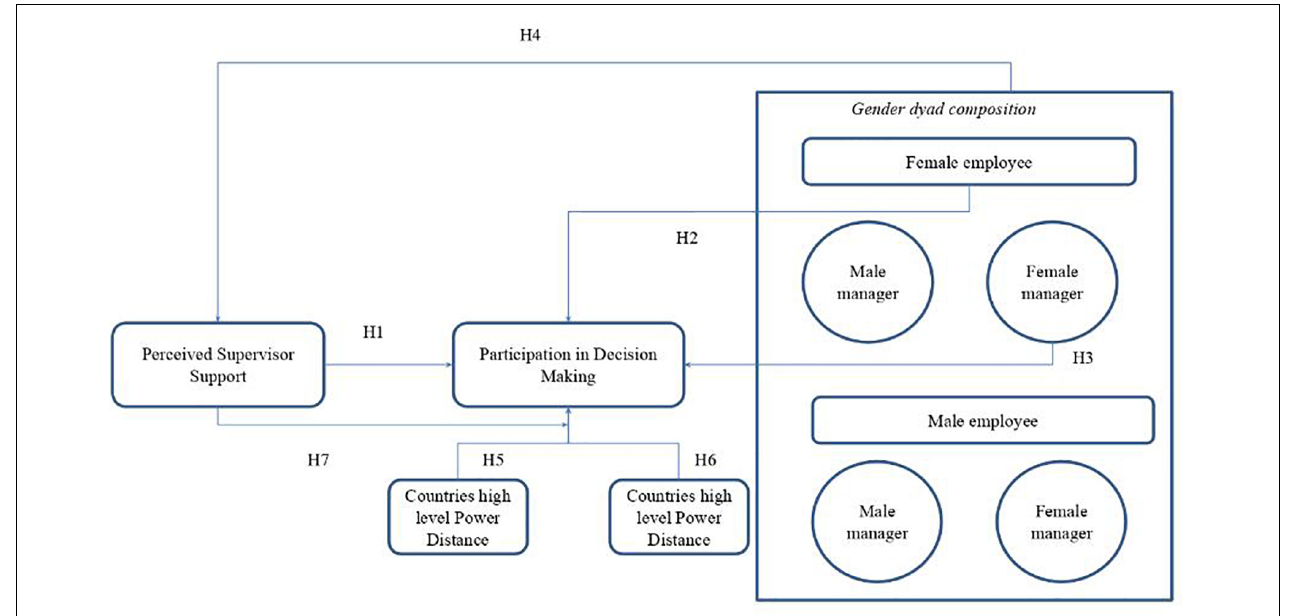
FIGURE 1 | Relations between variables and hypothesis.